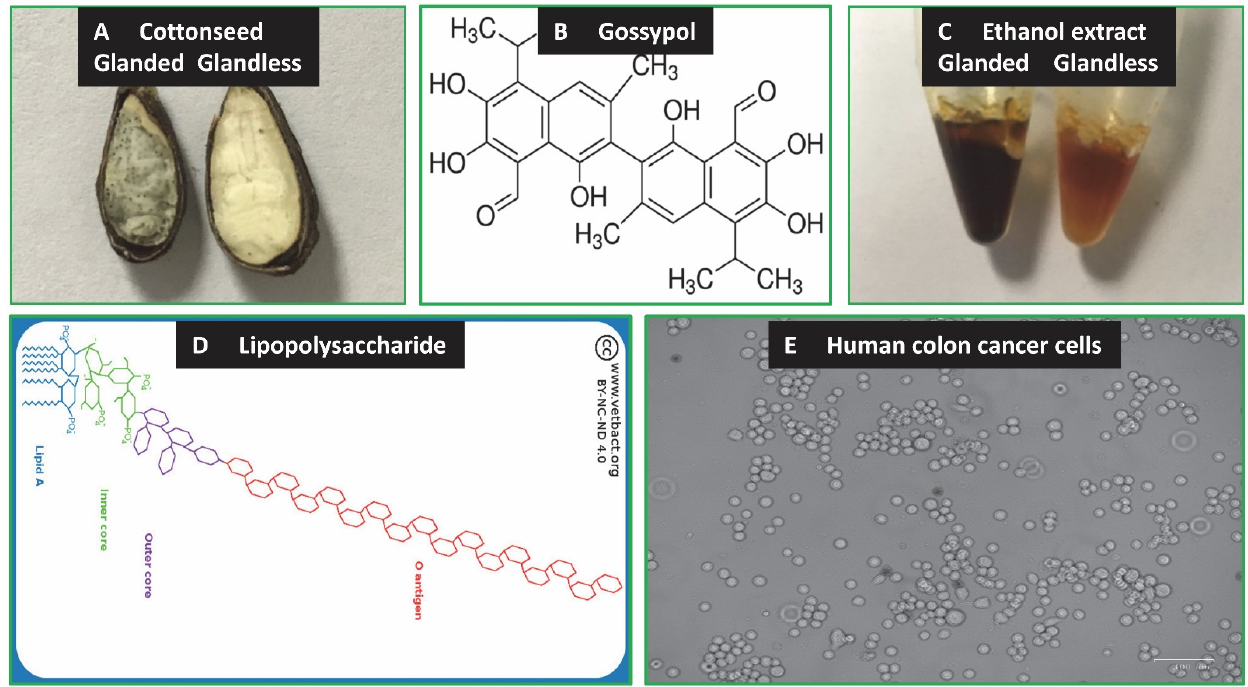
Figure 1. Cottonseed, cottonseed-derived gossypol and polyphenolic extracts, bacteria-derived LPS, and human colon cancer cells. ( A ) Cottonseed (glanded and glandless seed). Glanded seed